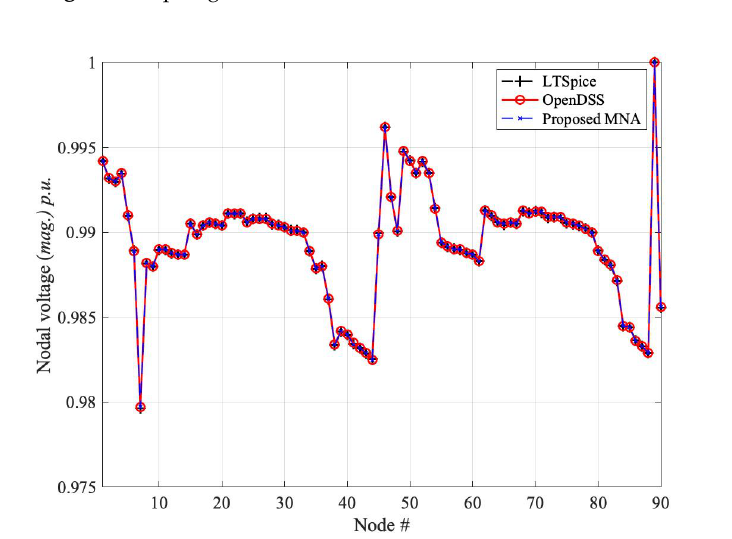
Figure 5. Topological structure considered for the Test90 test case.